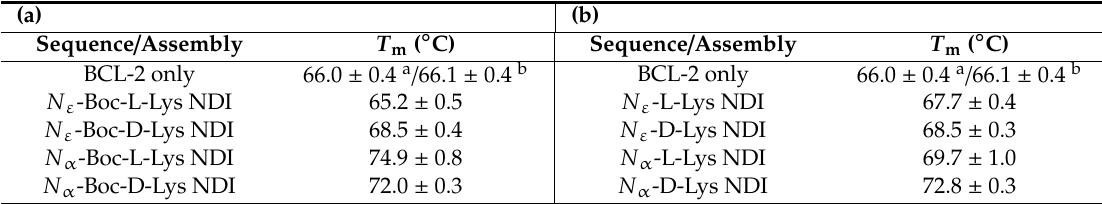
Figure 6. Graphical representations of mean Δ T m values obtained from VT CD studies of BCL-2 with 10 equivalents of ( a ) N α - and N ε -Boc- l - and d -NDIs as well as ( b ) N α - and N ε - l - and d -NDIs. Table 4. The T m values of BCL-2 only compared to the T m of ( a ) BCL-2-Boc-protected-NDIs and ( b ) BCL-2-deprotected-NDIs as determined from VT CD studies.